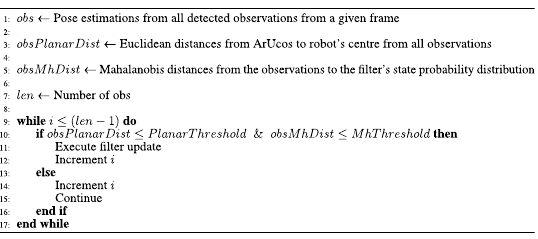
Algorithm 1. Filter update callback